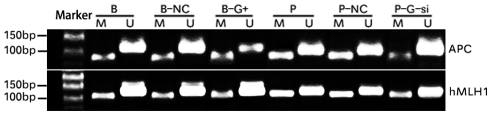
Up- or under-expression of GLI1 affected DNA methylation levels of APC but not hMLH1.Results of nested MSP of APC and hMLH1 in six kinds of PC cells respectively were shown. B represented BxPC-3 cells; B-G+ represented BxPC-3 transfected with pGC-FU-GLI1 to make GLI1 over-expression, and B-NC represented its negative control; P represented PANC-1; P-G-si represented PANC-1 transfected with GLI1-siRNA and P-NC represented its negative control. Positive bands under M and U represented the methylated and unmethylated DNA of the corresponding genes in the right panel, respectively.